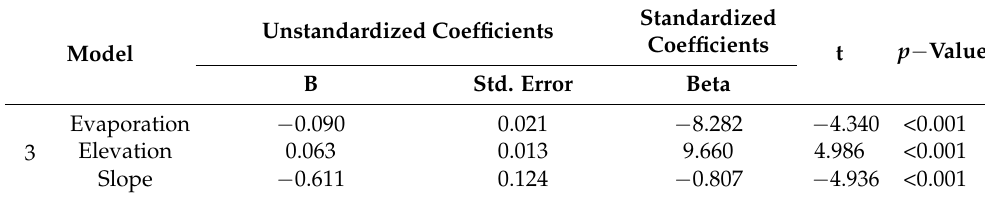
Table 4. Last run of